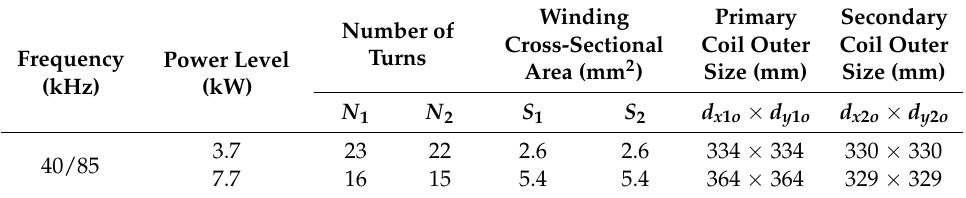
Table 1. The optimal parameters of coil dimensions for 3.7 kW and 7.7 kW WPT systems.